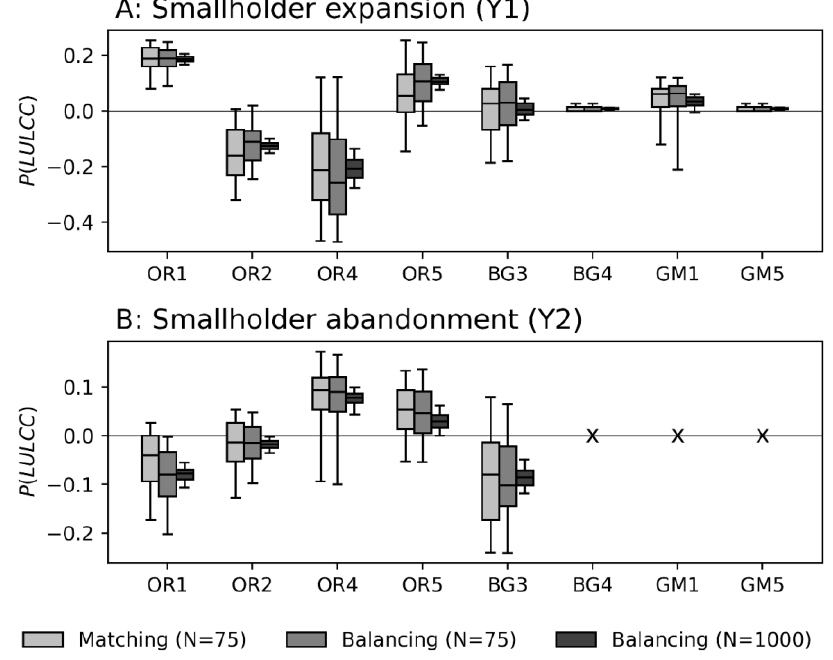
Fig. A4.5: Indirect LULCC estimates under different second-stage approaches. Matching (N=75) used genetic matching with 75 points sampled from each Treatment and Control Site. Balancing (N=75) used entropy balancing with 75 points and is the approach presented in the main manuscript. Balancing (N=1000) used entropy balancing with 1000 points, which violate assumptions of spatial independence and consequently lead to lower variability in the estimated